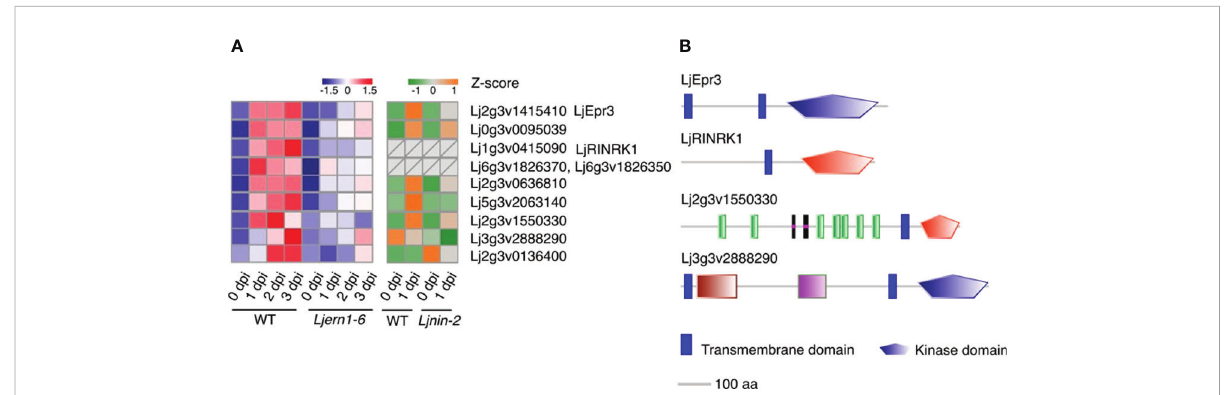
FIGURE 3 Expression of differentially expressed kinase genes in WT and mutants. (A) Heatmap of changes in the expression of differentially expressed kinase genes in the WT (MG-20) and Ljern1-6 mutants (left grid) and WT (Gifu) and Ljnin-2 mutants (right grid). (B) Receptor-like kinase prediction. Extracellular, transmembrane, and kinase domains were predicted using SMART (Letunic et al., 2015; Letunic and Bork, 2018); LjEpr3 and LjRINRK1 were used as positive controls. Blue stands for S_TKc, Serine/Threonine protein kinases, catalytic domain while red stands for STYKc, protein kinase; unclassi fi ed speci fi